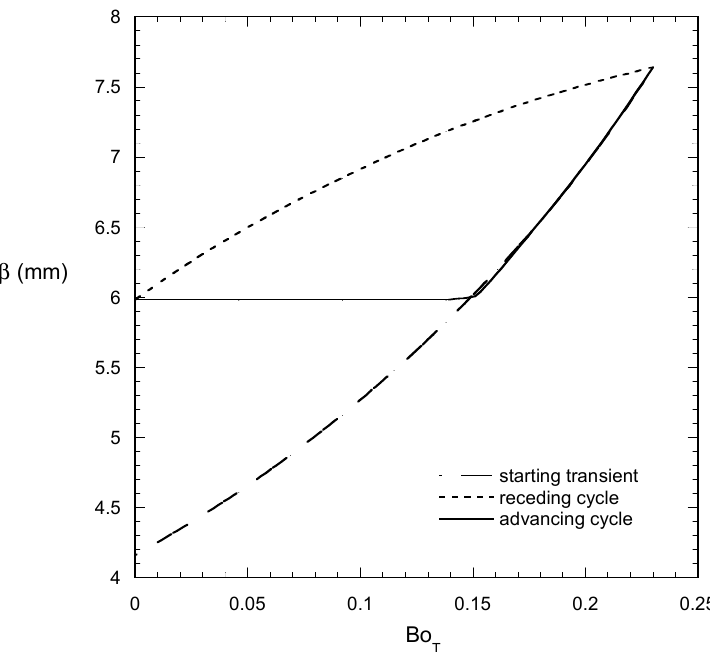
Figure 3. Evolution of droplet length β with Bo T for Bo N = 12 Bo T and periodic forcing (V A = 5 mm 2 , θ a = 60°, θ r = 40°, θ ο = 60°).